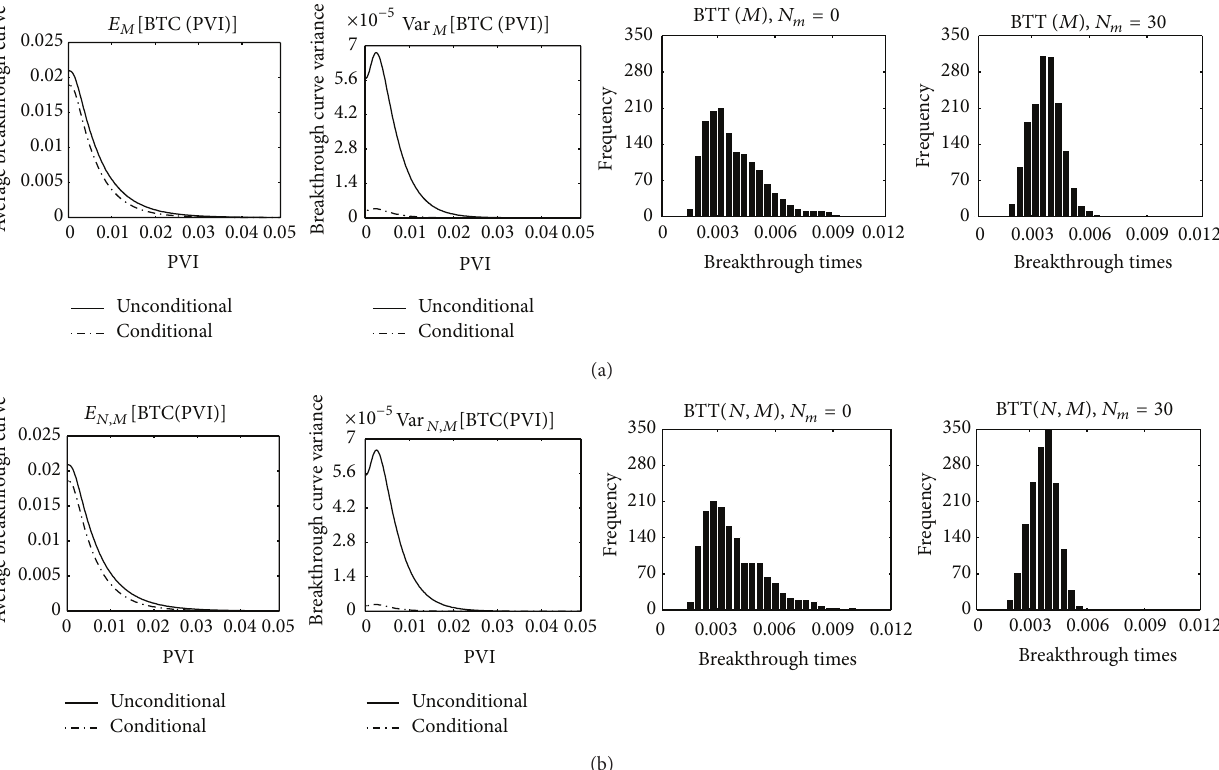
Figure8:TransportresultswithSGS-MC(a)andKL-MC(b)with 𝑀 = 1600 .Fromlefttoright:momentsofbreakthroughcurvesBTC ( PVI ) , and histograms of breakthrough times BTT.